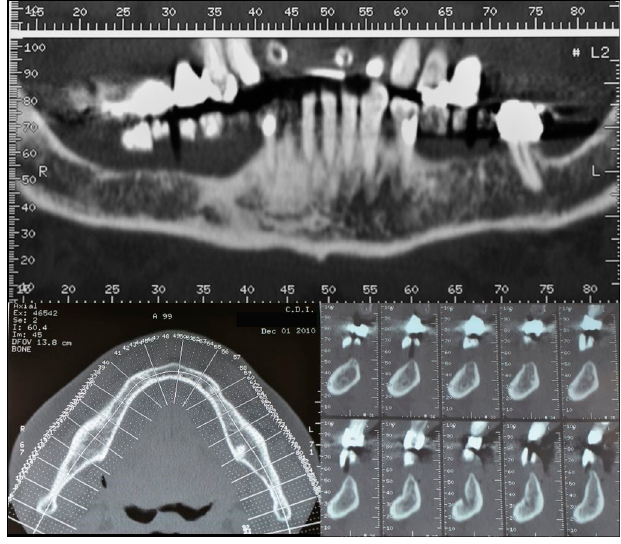
Figure 2. CT scans showing the horizontal atrophy in the lower right quadrant.